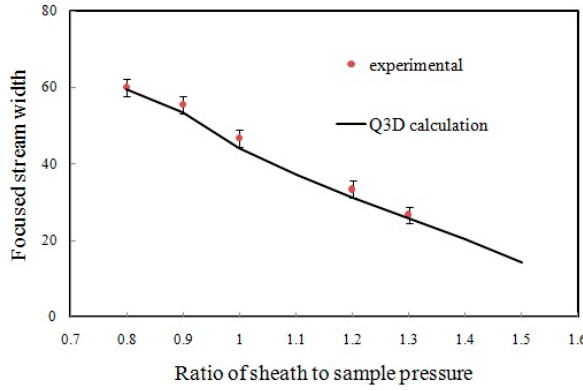
Figure 14. Experimental and simulated focused stream width as a function of focusing strength.